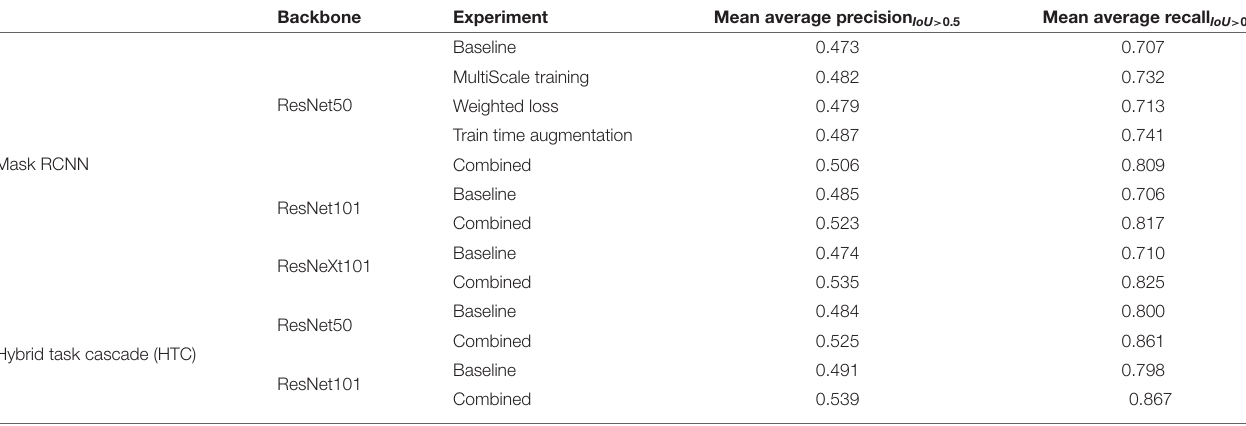
TABLE 2 | Mean Average Precision (mAP) and mean Average Recall (mAR) scores from the Mask RCNN and Hybrid Task Cascade(HTC) experiments across different experimental configurations on the Round 4 problem formulation and test set.